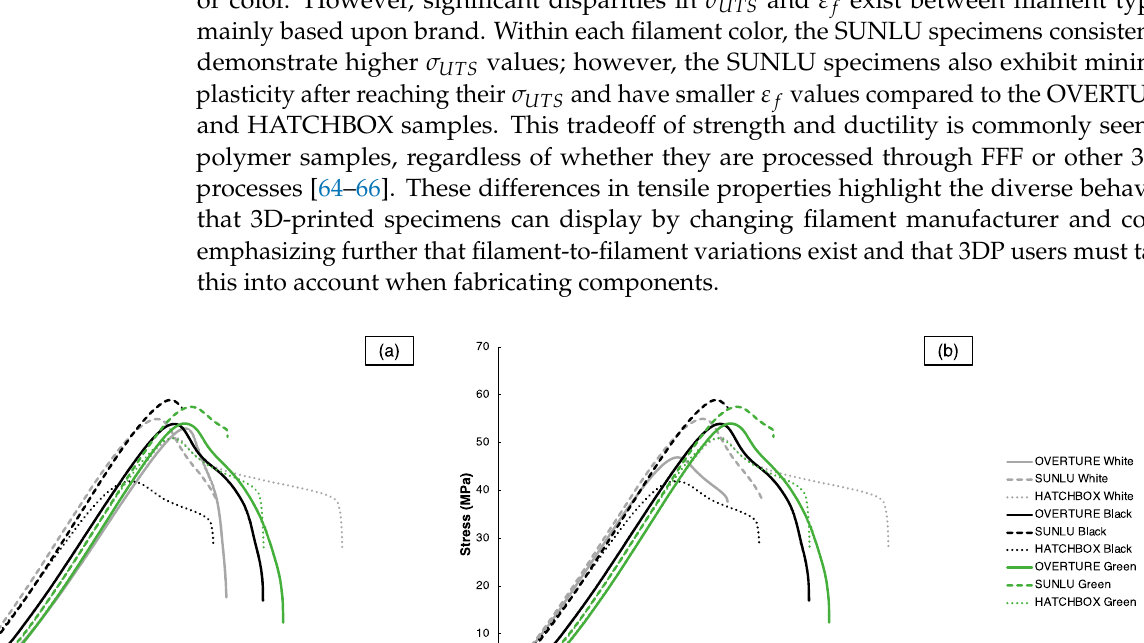
Table 3. Filament scoring across all four printer conditions, with varying bed temperature and bed surface, produces 𝑆 (cid:3004)(cid:3042)(cid:3040)(cid:3029)(cid:3036)(cid:3041)(cid:3032)(cid:3031) values based upon the contributions from dimensional accuracy and mechanical properties (* optimal parameter set identi fi ed for a given fi lament).